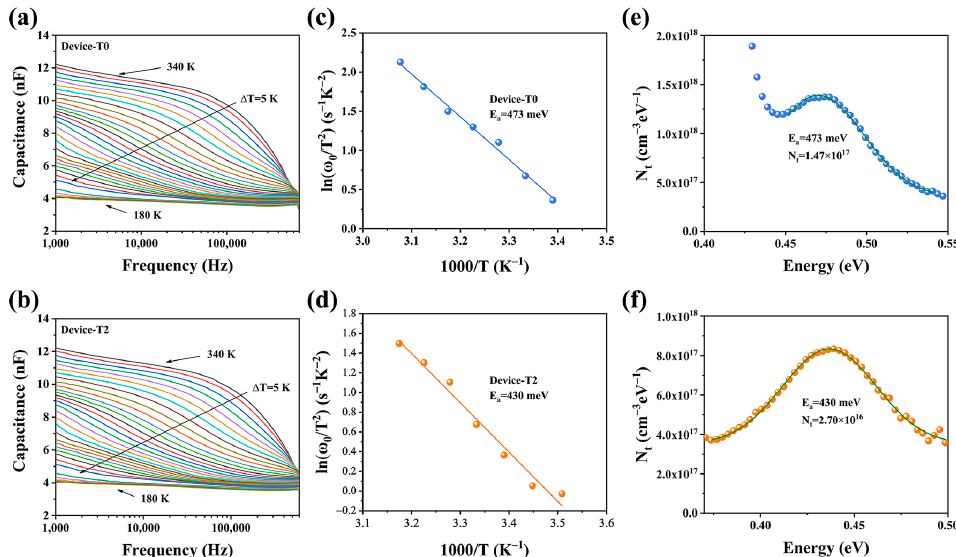
Figure 7. ( a , b ) Capacitance − frequency − temperature (C − f − T) spectra (Different colored lines repre- sent capacitance values at different temperatures), ( c , d ) Arrhenius plots of the T0 and T2 devices, and ( e , f ) defect densities of T0 and T2 devices,